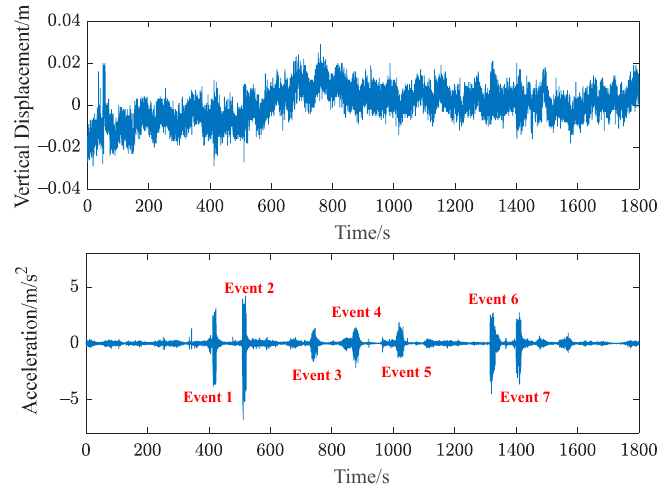
Figure 10. Wilford Bridge vertical GNSS displacement and acceleration.